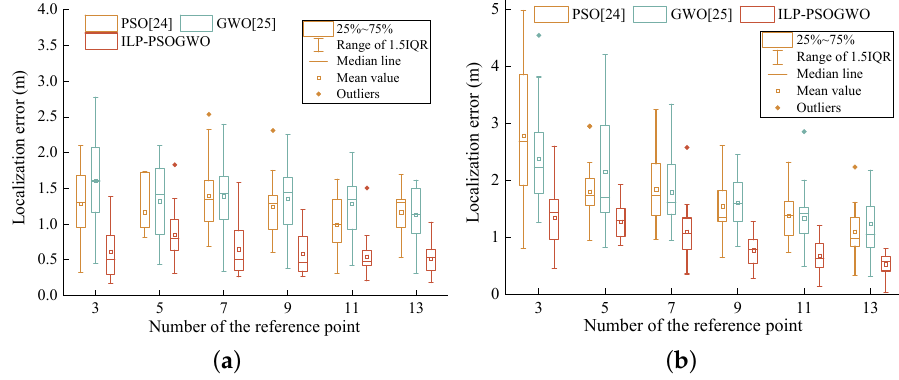
Figure 14. Impact of the number of reference point on localization error. ( a ) LOS. ( b )